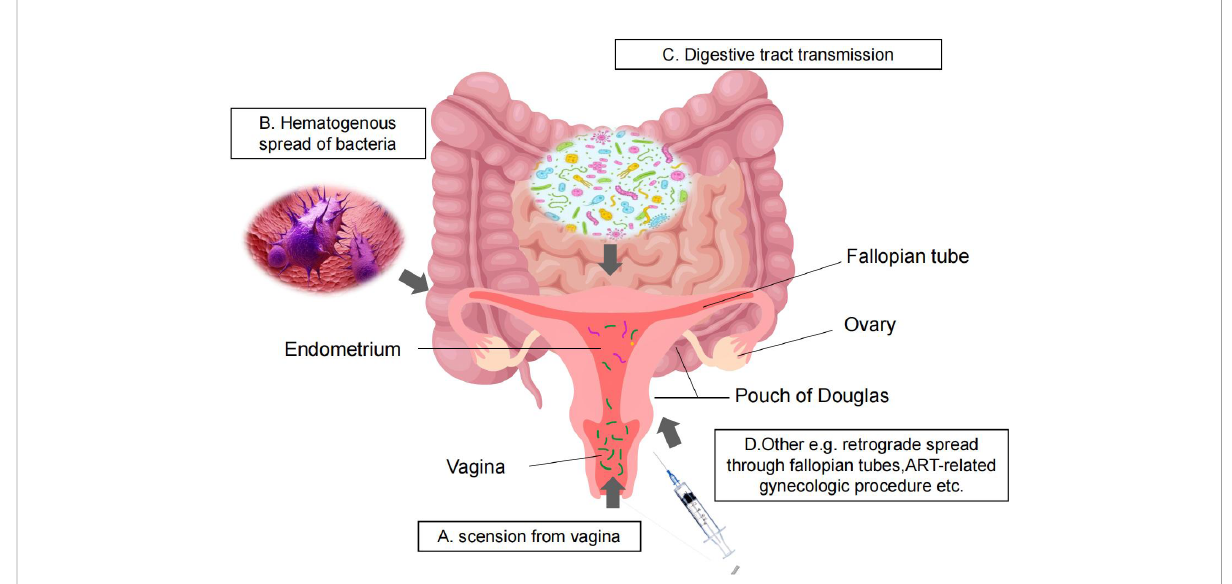
FIGURE 2 Womb microbiota transmission pathways. (A) scension from vagina; (B) Hematogenous spread of bacteria; (C) Digestive tract transmission; (D) Other e.g. retrograde spread through fallopian tubes,ART-related gynecologic procedure